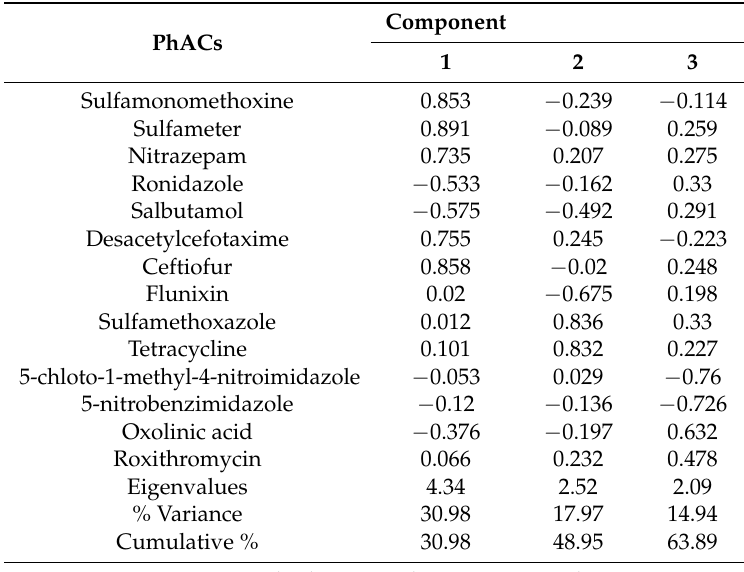
Extraction Method: Principal component analysis. Rotation Method: Varimax with Kaiser